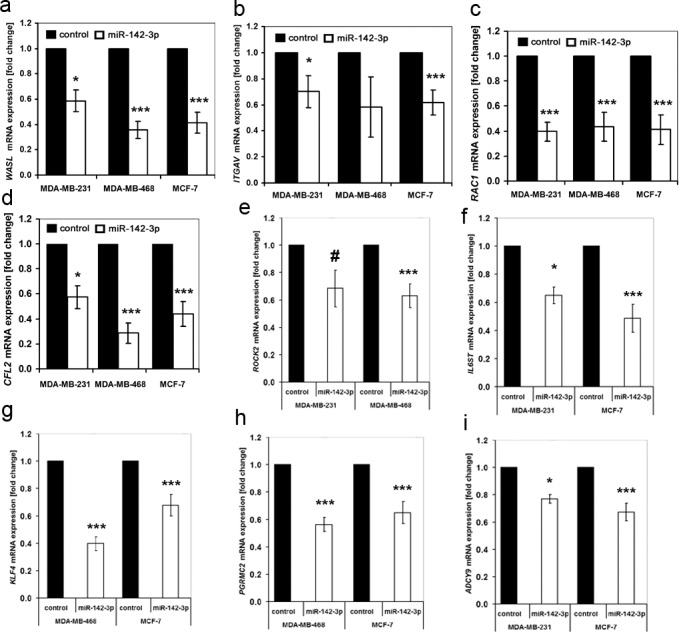
Confirmation of differentially regulated mRNA targets in miR-142-3p vs control transfected breast cancer cell lines by qPCR.Cells were transfected with a control miRNA, miR-142-3p or antimiR-142-3p as described in the methods section, followed by RNA and cDNA preparation and qPCR analysis. (a-i). Black columns = control, white columns = miR-142-3p precursor, N>6, error bars = SEM, #P = 0.052 (n.s.), *P<0.05, ***P<0.001. miR-142-3p upregulation inhibits expression of WASL (a), ITGAV (MDA-MB-231; MCF-7) (b), RAC1 (c), CFL2 (d), ROCK2 (MDA-MB-231 with P = 0.052, MDA-MB-468) (e), IL6ST (MDA-MB-231, MCF-7) (f), KLF4 (MDA-MB-468, MCF-7) (g), PGRMC2 (MDA-MB-468, MCF-7) (h), and ADCY9 (MDA-MB-468, MCF-7) (i).